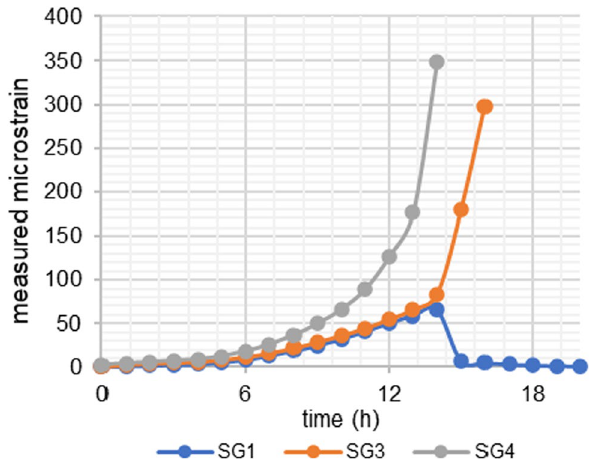
Fig. 7 Measured strains in specimen G-SL1-100-500-M-02